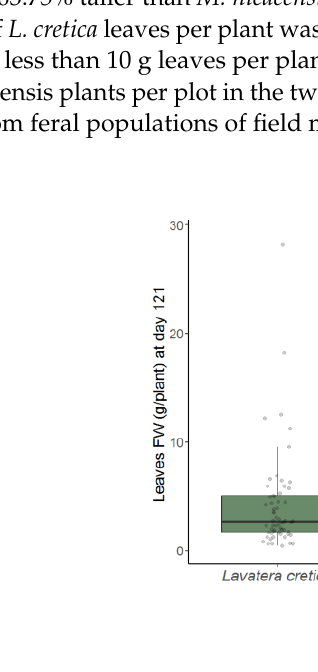
( b ) Figure 2. Development of L. cretica and M. nicaeensis in nitrogen (N) enrichment net house experiment (2020 – 2021). High and low indicates fertigation with 180 ppm and 120 ppm, respectively. Each dot represents an individual plant; dots are distributed horizontally for visual clarity. Median is indicated as a horizontal line within the box plot. ( a ) Plant height after 50 days; ( b ) Leaf FW per m 2 after 77 days. ns stands for Not Statistically Significant. Under N-enrichment, growth of M. nicaeensis was similar to that of L. cretica . With sufficient N supply, M. nicaeensis and L. cretica cultivated in the field, or in feral popula- tions, yielded 2698 ± 1363 kg green leaf FW per hectare. An average 14 ± 7 and 21 ± 11 leaves per L. cretica and M. nicaeensis plant, respectively were measured in the cultivated field 50 days after sowing. After 57 days of growth, L. cretica and M. nicaeensis leaf weights were 63 ± 1% and 66 ± 0% of their total shoot weights, respectively. This proportion was drastically reduced within only three weeks, i.e., 77 days after sowing, when leaf weight